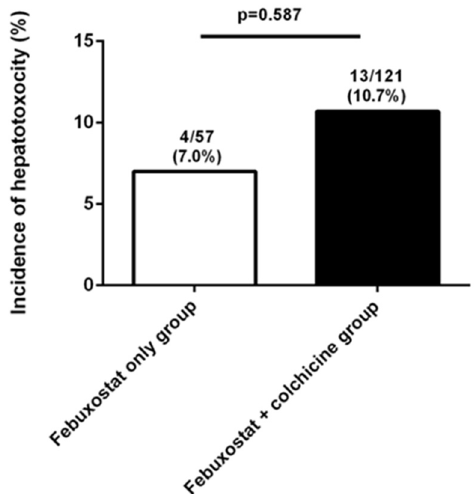
Figure 1. Incidence of hepatotoxicity between the groups with or without colchicine in patients with gout treated febuxostat.